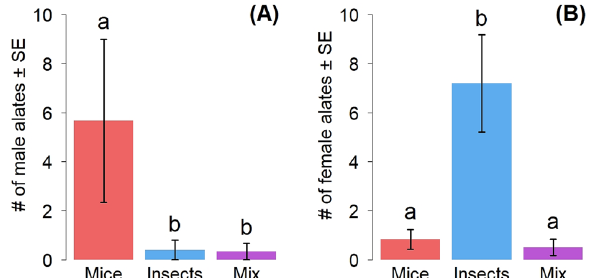
Figure 4. ( A ) Number of male alates counted in experimental colonies (mean ± SE) and ( B ) number of female alates counted in experimental colonies (mean ± SE) as functions of food treatments. Red = mice (n = 6), blue = insect (n = 5), purple = mix (n = 6). Letters above bars represent the results of the post-hoc pairwise comparison analysis. Bars sharing a letter are not significantly different (P <